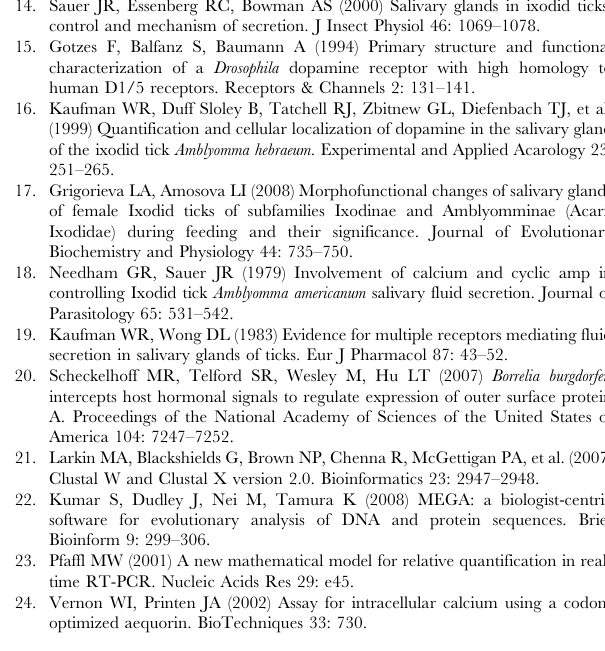
Figure S2 Pre-immune negative controls for D1 recep- tor. (A) acinus II and (B) acinus III of unfed female. Scale bar 10 m m. Doted lines indicate the boundary of an